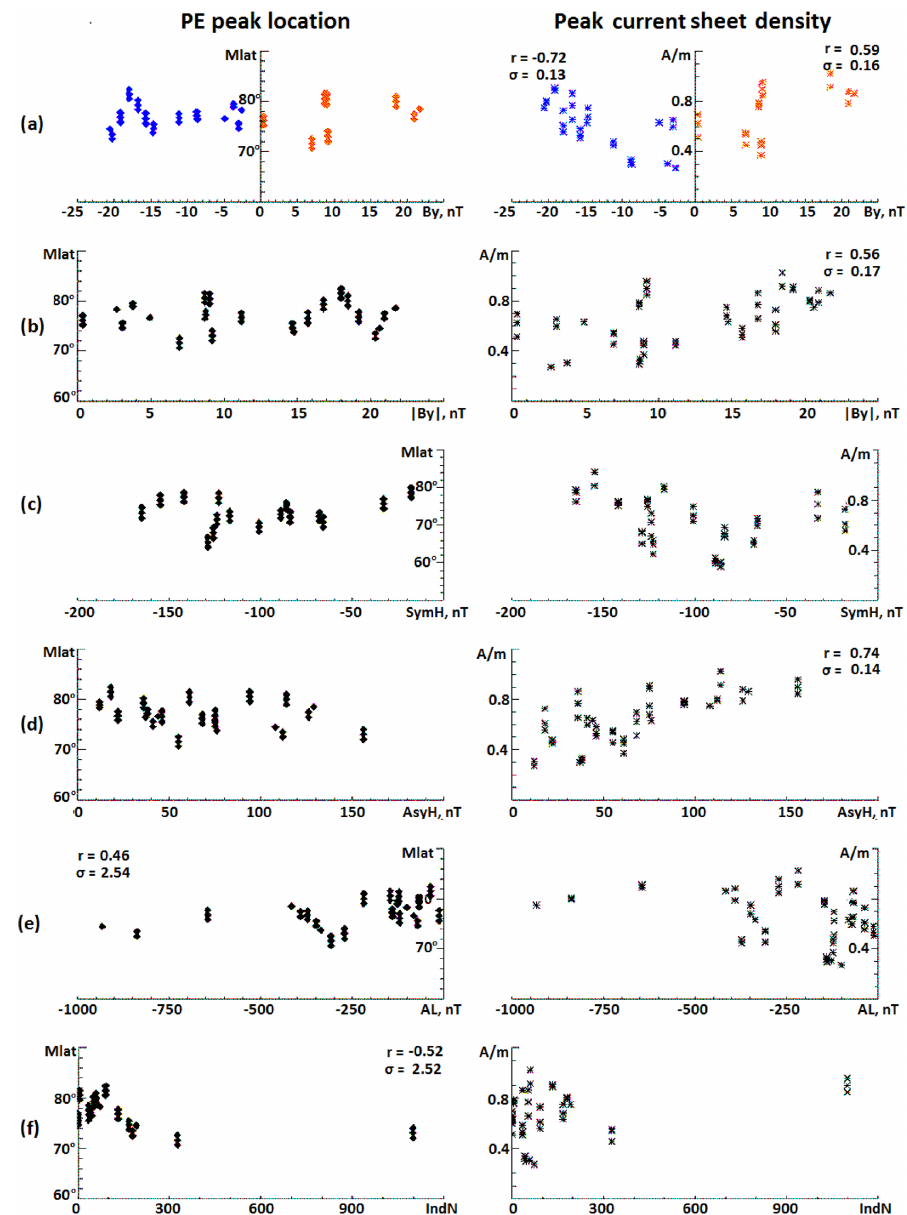
Figure 3. Dependence of the magnetic latitude MLat (degrees) position at the peak (left column) and the intensity ( I in Am − 1 , right column) in the Hall current of the polar electrojet (PE) on the IMF B y component (a) and its magnitude (b) in the geomagnetic activity indices SymH (c) , AsyH (d) , AL (e) , and the solar wind coupling function IndN (f) . The blue and red data points indicate westward and eastward currents, respectively. For the cases of correlation with r > 0 . 46, the correlation coefficients ( r ) and the dispersion ( σ ) according to a linear regression are shown as